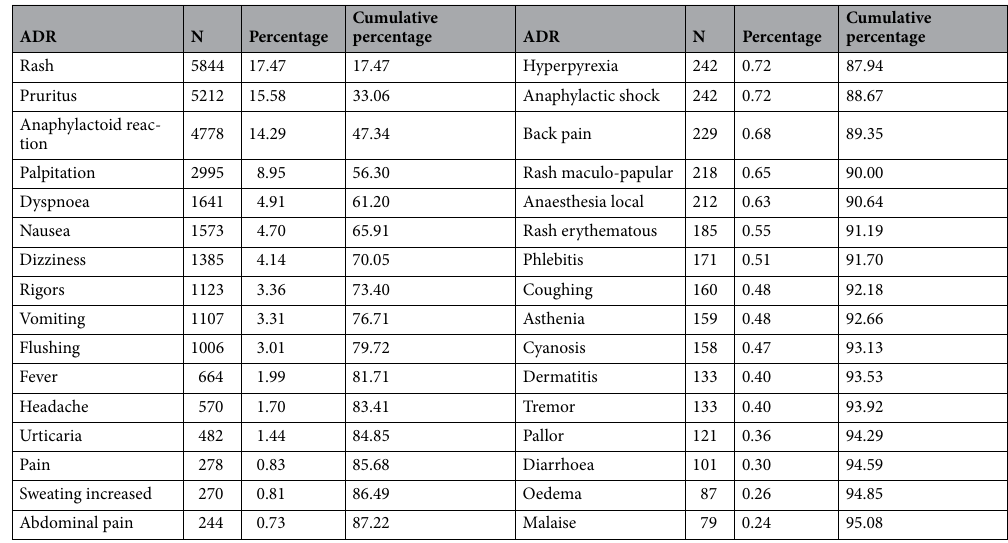
Table 5. Number and proportion of ADRs (n = 33,446).